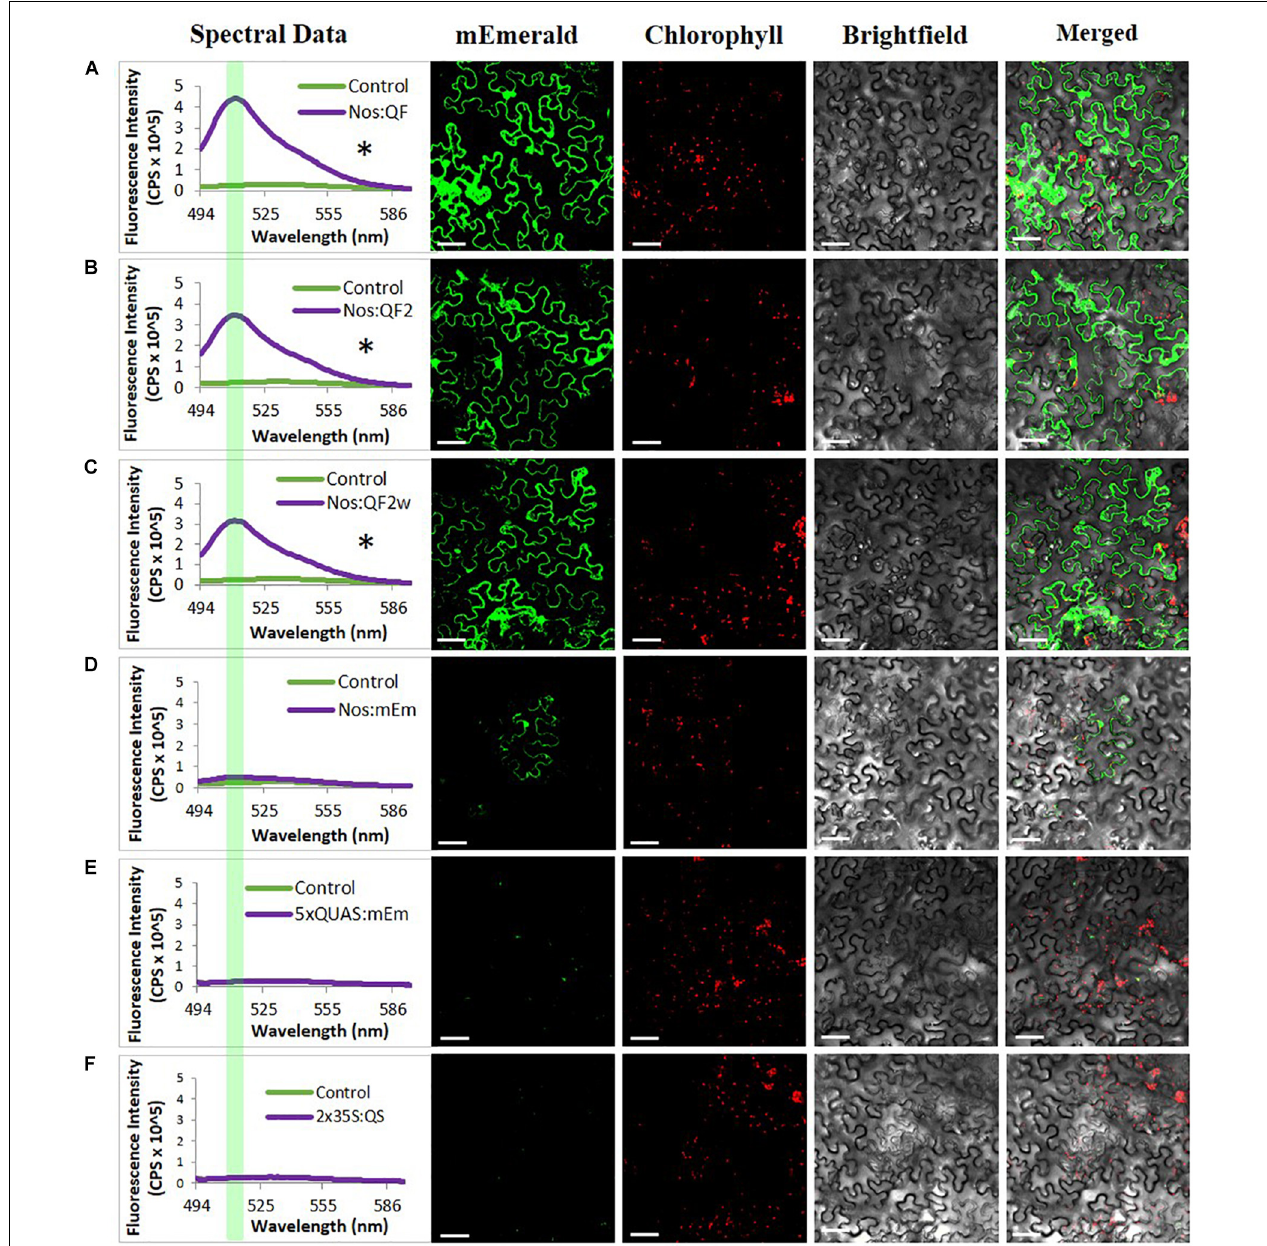
FIGURE 3 | Signal amplification using Q-system variants QF, QF2, and QF2w. Spectral counts and confocal micrographs from (A) Nos:QF; (B) Nos:QF2; (C) Nos:QF2w; (D) Nos:mEmerald; (E) 5xQUAS:mEmerald; and (F) 2 × 35S:QS. Spectral data represent mEmerald emission of agroinfiltrated N. benthamiana leaves using the indicated constructs. With QF, QF2, and QF2w constructs, significant expression is observed relative to the empty vector control. The highlighted portion of the spectral data indicates peak mEmerald emission at 509 nm. Confocal micrographs allow for visual confirmation of the spectral data with the QF, QF2, and QF2w constructs easily observable. Statistical significance determined for all data points across spectrum using one-way repeated measures ANOVA, post hoc Tukey HSD). Asterisk (*) indicate significant difference of p < 0.05 compared to plants infiltrated with LBA4404 as a control and plants with the Nos:mEmerald construct. Data represent mean ± standard error of three independent experiments ( n = 3). Three technical replicates were collected for each biological replicate to account for positional